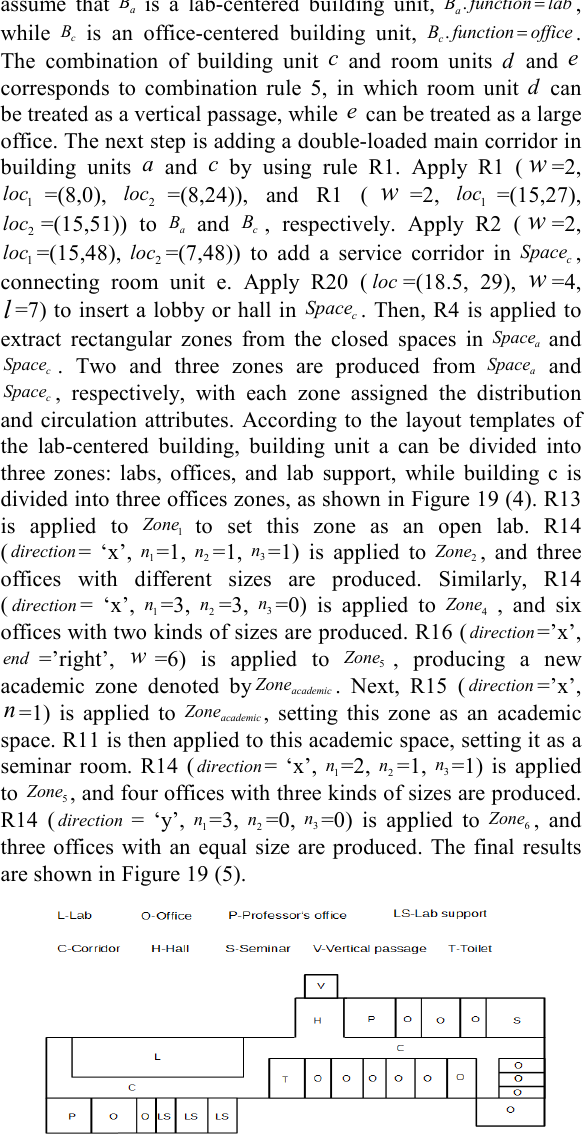
Figure 18. True map of test building